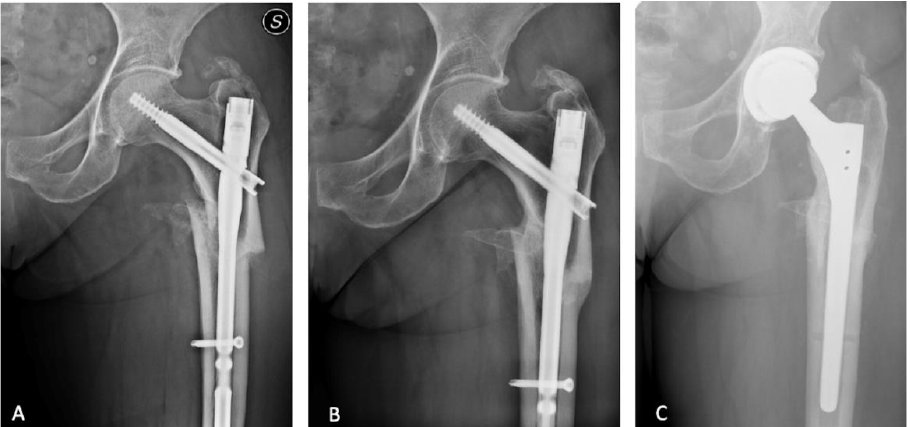
Figure 1. ( A ) Left pertrochanteric hip fracture treated with proximal femoral nail. S means left. ( B ) Fracture healed with varus and torsional deformity. ( C ) Left uncemented total hip arthroplasty with long revision conical stem.